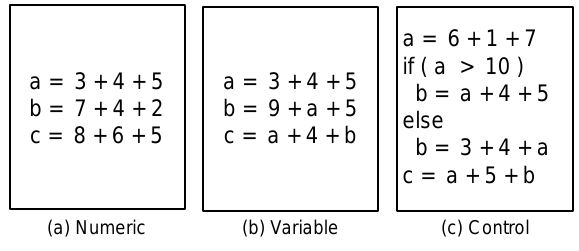
Fig. 3. Example of Program